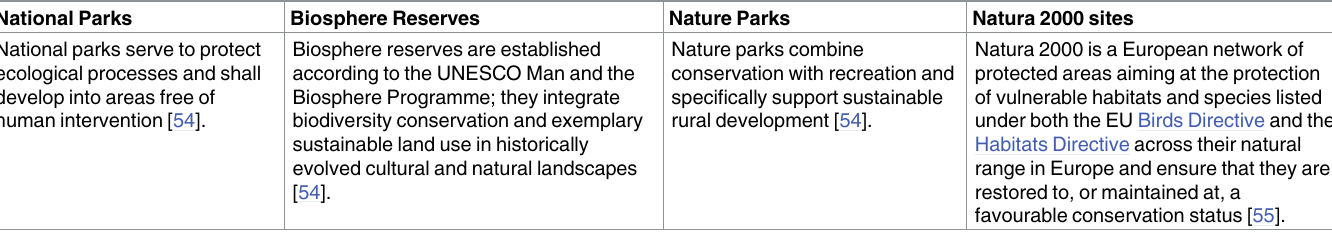
Table 1. Short description of the four protected area categories selected for the analysis (for more detailed description see S1 Text). National